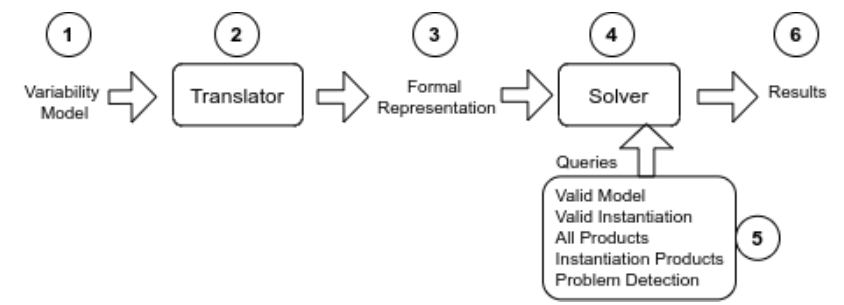
Figure 1. General Process for Automated Analysis of Variability